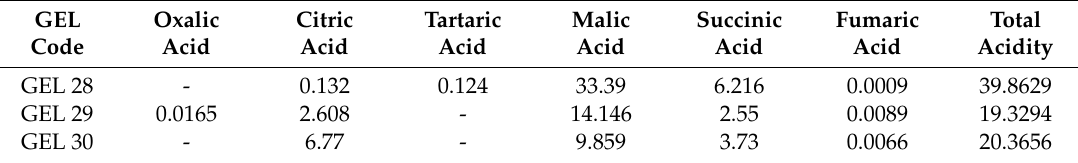
Table 2. Content of organic acids (mg / g gel) in bleaching gels from HPLC analysis.